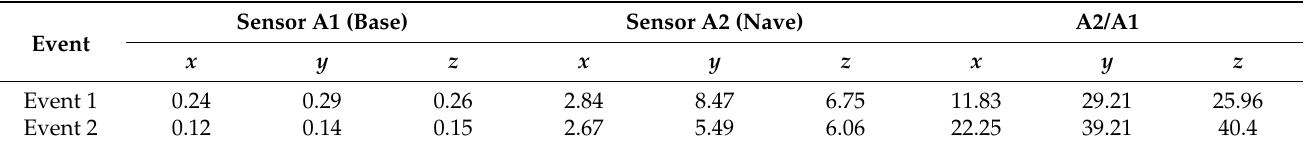
Figure 4. Seismic response of the Church of Jer ó nimos Monastery, Portugal (adapted from [46,47]): ( a ) exterior view; ( b ) location of strong motion recorders (A1: chancel base; A2: nave vault extrados); ( c , d ) acceleration response at the base and at the top of the nave during the earthquake; ( e ) measured response spectra. Table 1. Dynamic amplification recorded in of the Church of Jer ó nimos Monastery, Portugal, during the earthquake of 12 February 2007 (maximum results of acceleration in